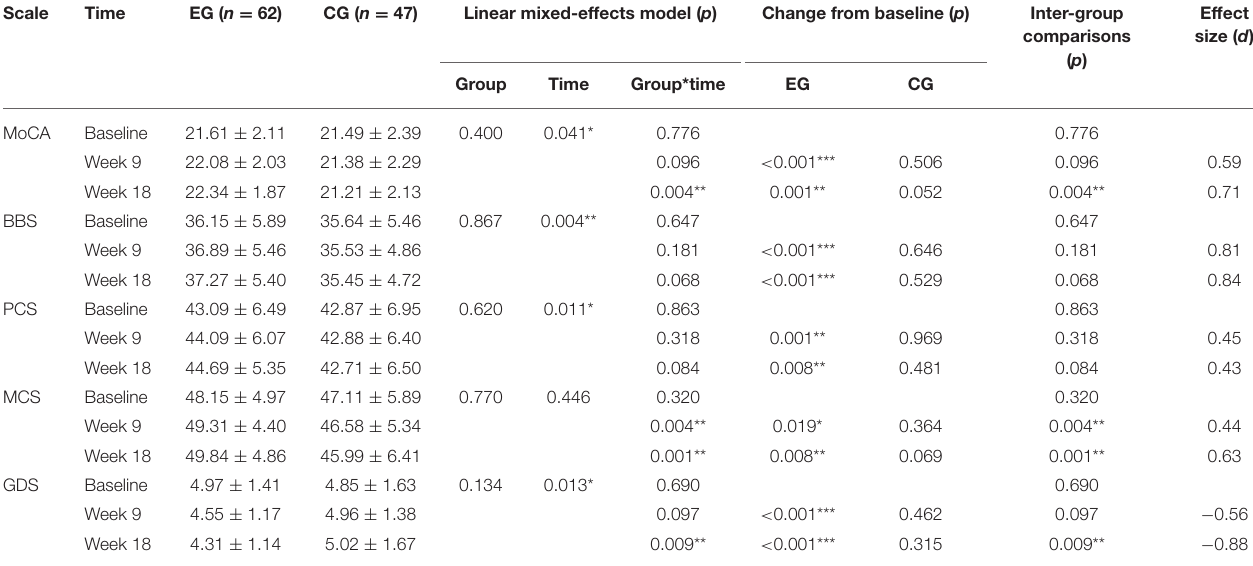
TABLE 2 | Comparison of the experimental and control groups across time.